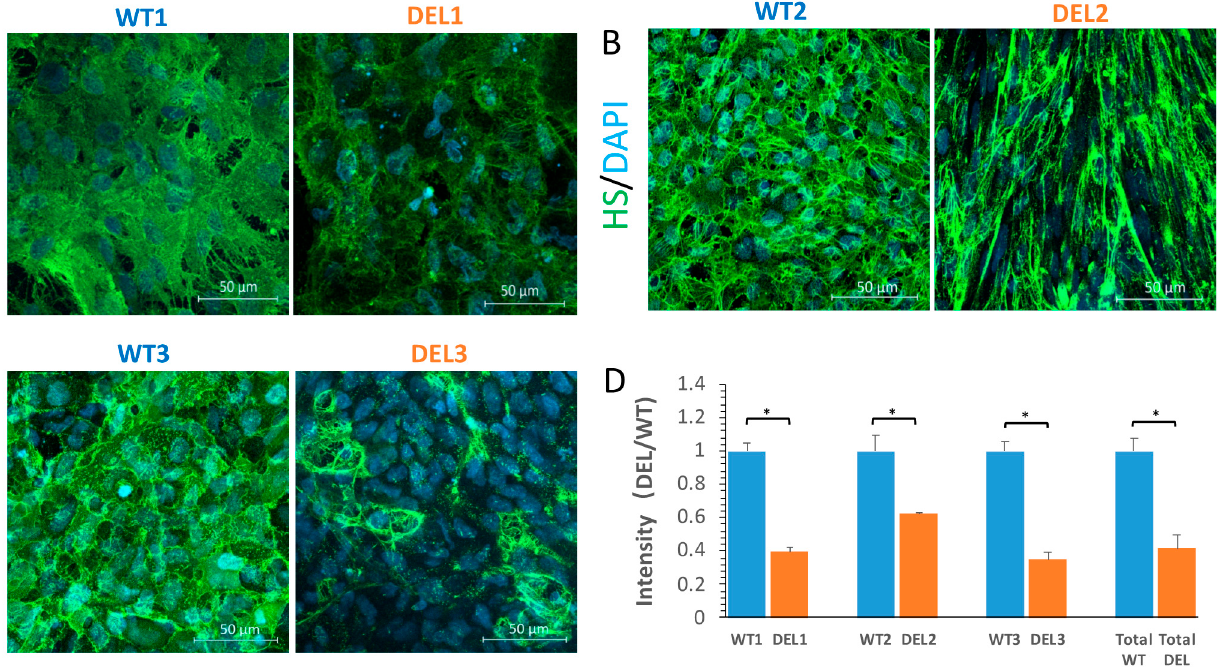
Figure 3. Comparison of the ESG at the iBBB between control (WT) and 22q11.2DS-SCZ (DEL). Confocal images showing heparan sulfate (HS) of the ESG at the iBBB for the control (left panel) and 22q11.2DS-SCZ (right panel) from 3 paired iPSCs ( A – C ). ( D ) Normalized HS intensity at the iBBB for the control and 22q11.2DS-SCZ. n = 3 samples with 9 fields (each field 320 μ m × 320 μ m) analyzed for each case. * p < 0.05.